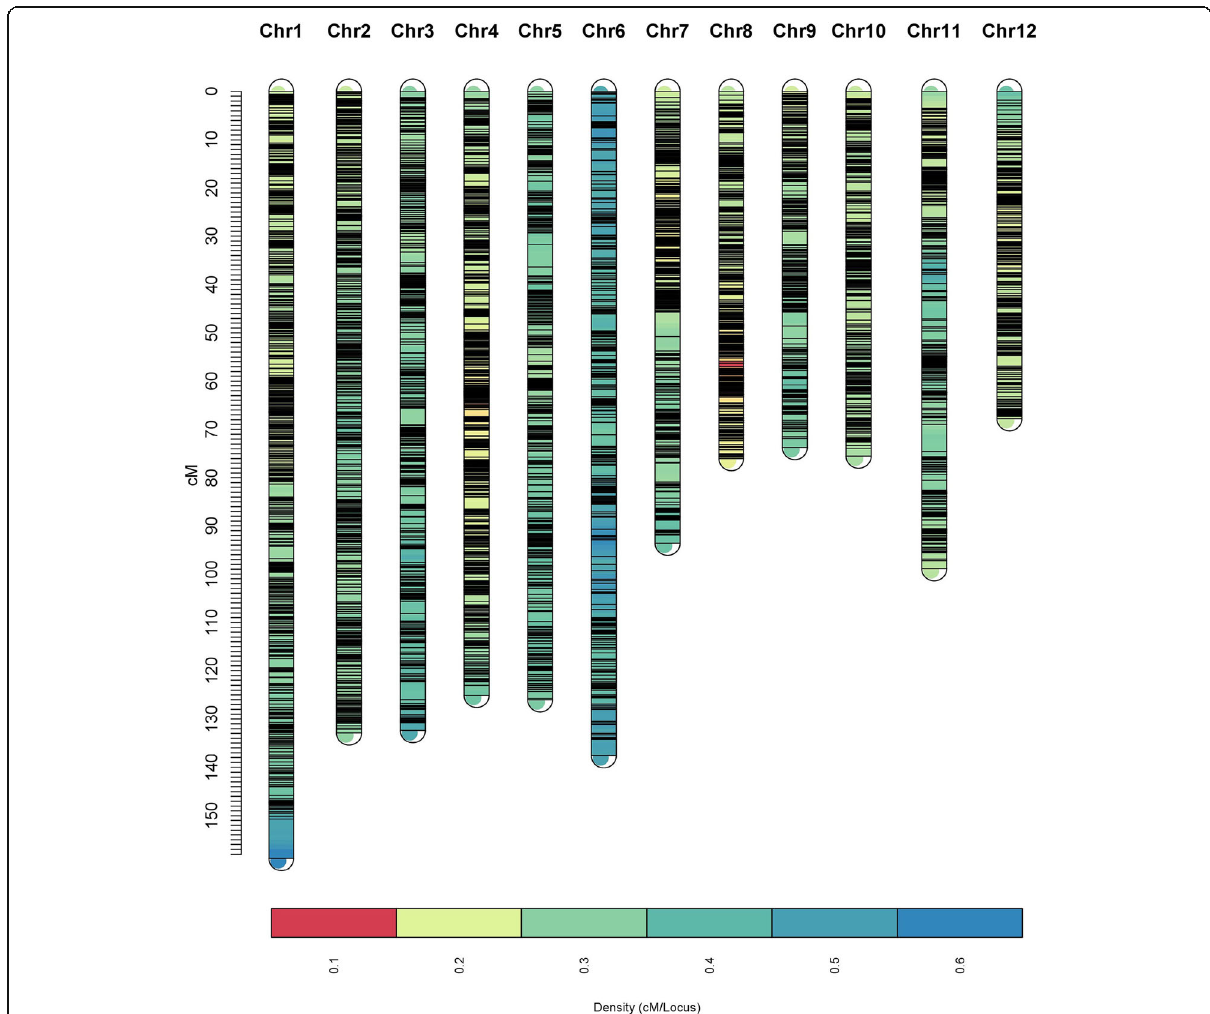
Fig. 2 Linkage map constructed by GAPL from